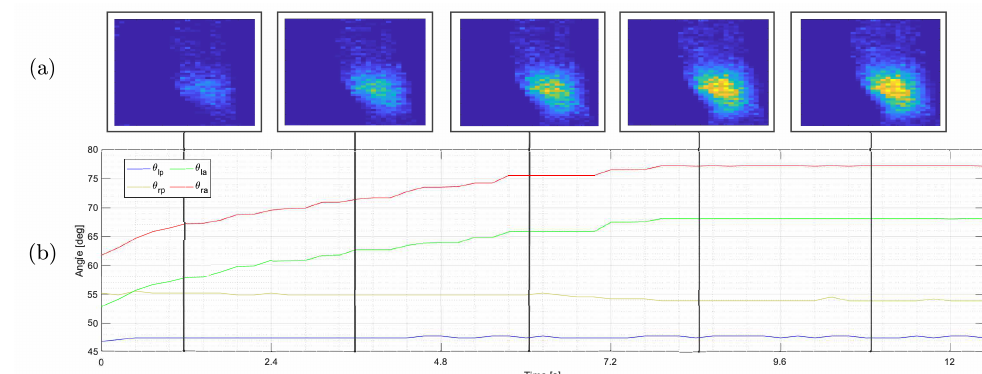
Figure 5. Time sequences of tactile and kinesthetic information are excerpted during the grasping process. A collection of tactile images composing tactile information ( a ). Five tactile images are presented in this figure to demonstrate how the pressure distribution evolves along the sequence, distinguishing the bones and muscles of the forearm. The variation in the joint position of the underactuated fingers’ joints produces kinesthetic information ( b ). Here, θ la and θ ra denote the left and right fingers’ actuated joint angles, respectively, while θ lp and θ rp denote the left and right fingers’ underactuated joint